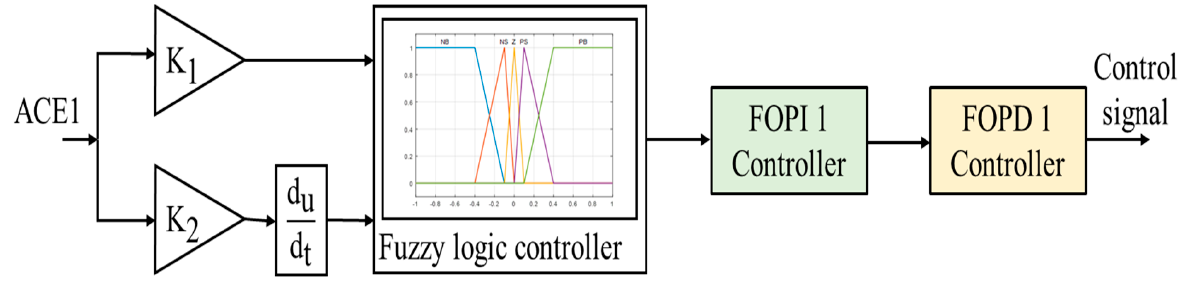
Figure 2. The structural design of the proposed FC FOPI-FOPD controller.